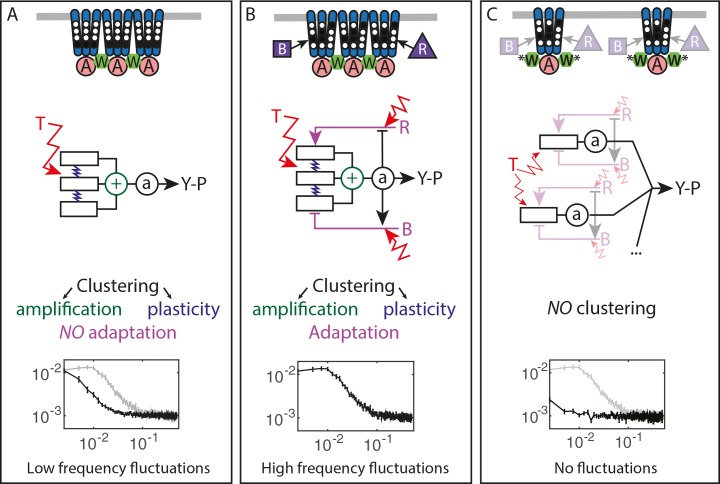
Multiple sources of signaling fluctuation in the chemotaxis pathway.(A) In the absence of adaptation enzymes, thermal fluctuations stimulating – and amplified by – the dynamic receptor cluster lead to low frequency fluctuations (<0.01 Hz) around intermediate cluster activity. The blue springs symbolize the plasticity of the receptor array, the green ⨁ its cooperativity. (B) In adapted wild-type cells, thermal fluctuations and fluctuations in the dynamics of CheR and CheB are amplified by the dynamic chemoreceptor cluster, which leads to fluctuations of the activity at frequencies around 0.03 Hz. (C) In the absence of clustering, responsive but non-amplifying receptor complexes do not produce observable activity fluctuations, whether or not adaptation enzymes are present. Graphs show the PSD of the FRET ratio measured in each respective case (black). In (A,C) the wild-type curve is shown for comparison (gray).